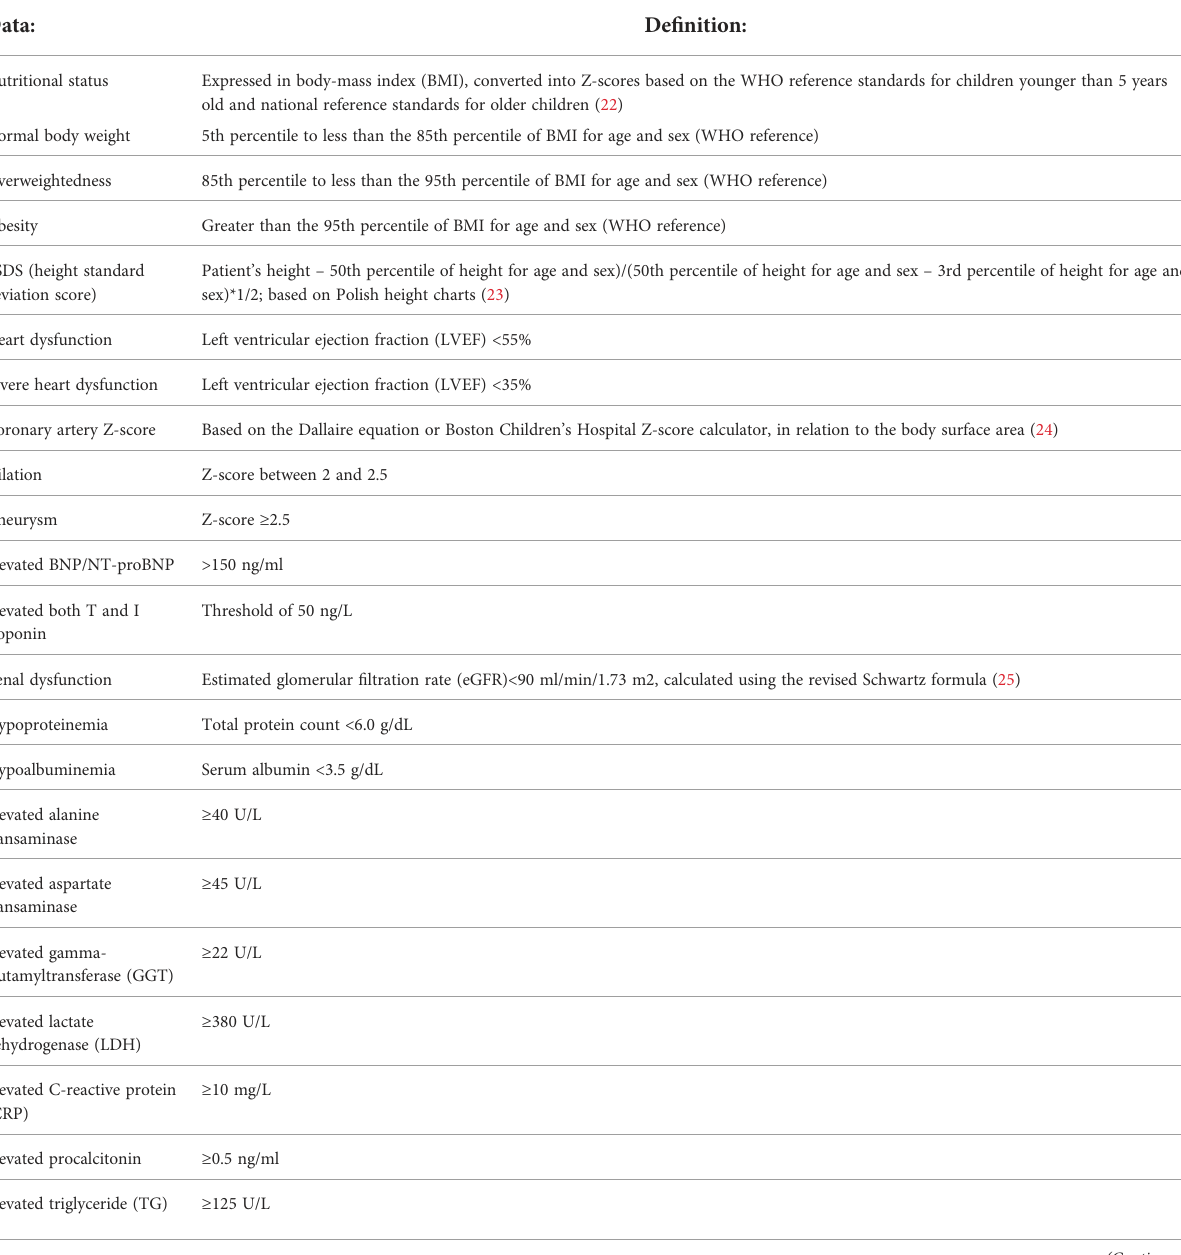
TABLE 2 Clinical and biochemical status de fi nitions.